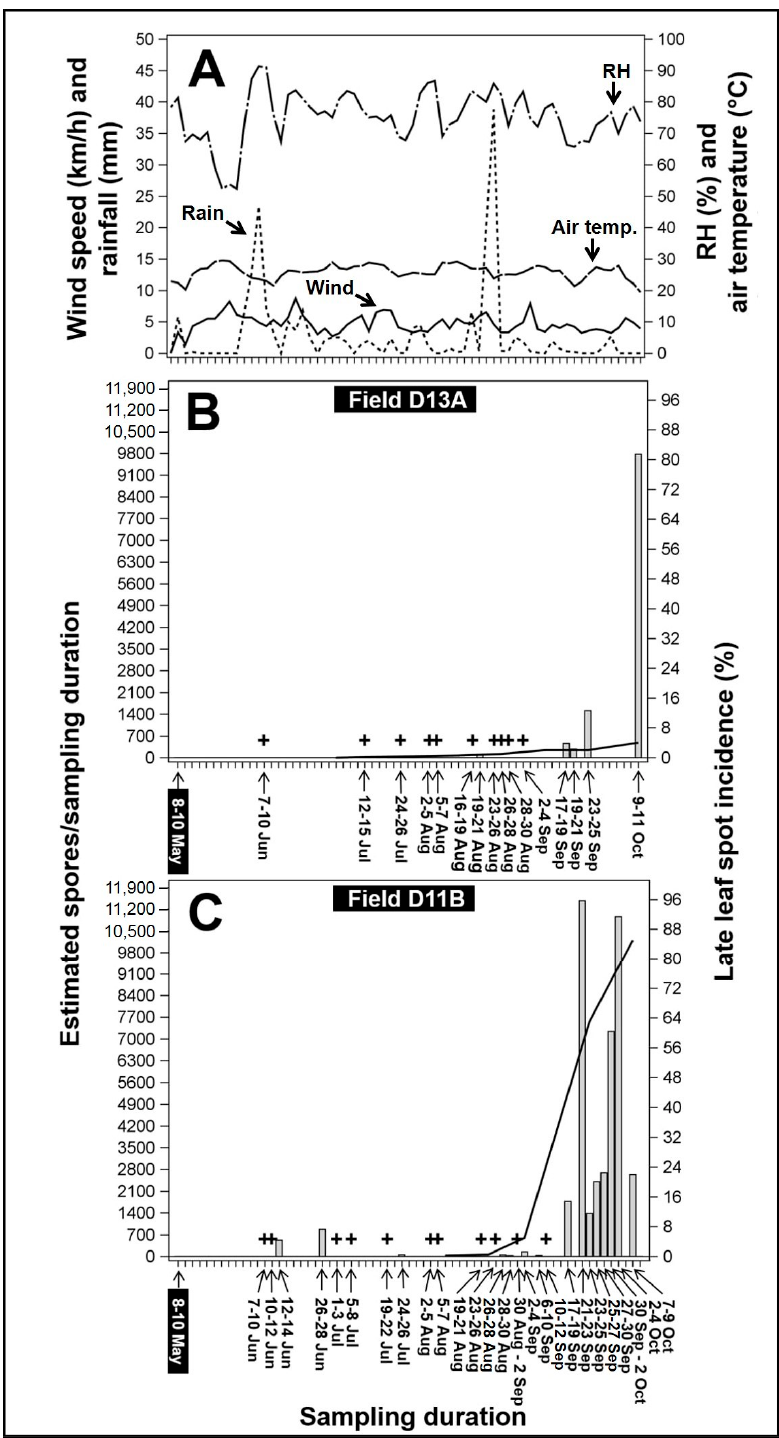
Figure 3. Weather data, inoculum detection, and late leaf spot (LLS) incidence during the 2019 growing season in Blackville, SC. ( A ) Weather data: dashed short line = average accumulated rainfall, solid line = average wind speed, dashed long line = average temperature, and dashed long and short line = average relative humidity (RH). ( B ) Estimated trapped Nothopassalora personata spores and LLS incidence in field D13A and ( C ) field D11B. (+) = positive detection below limit of quantification, bars = estimated number of spores collected on the spores/trap per sampling duration, and solid line = % LLS incidence. Magnified bar graph for estimated number of spores <700, is provided in a supplementary figure (Figure S4).